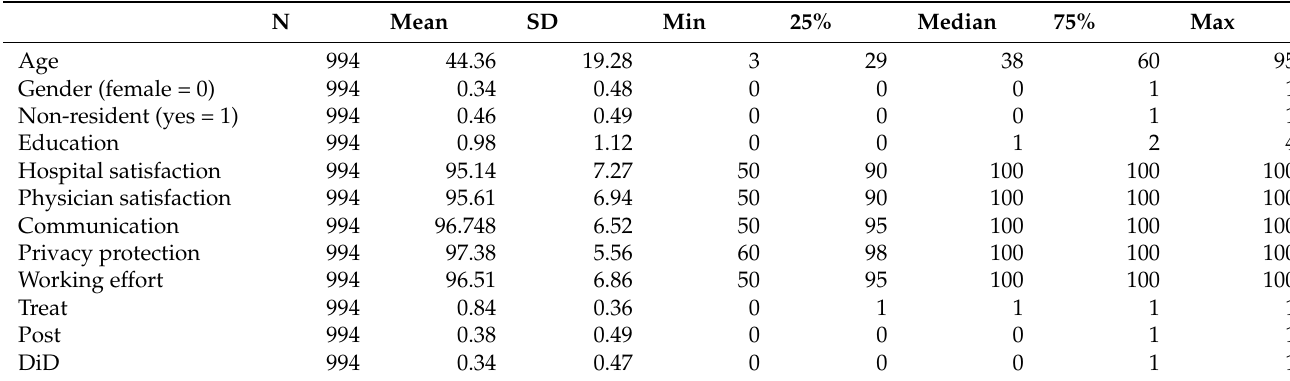
Table 2. Summary statistics of the variables.